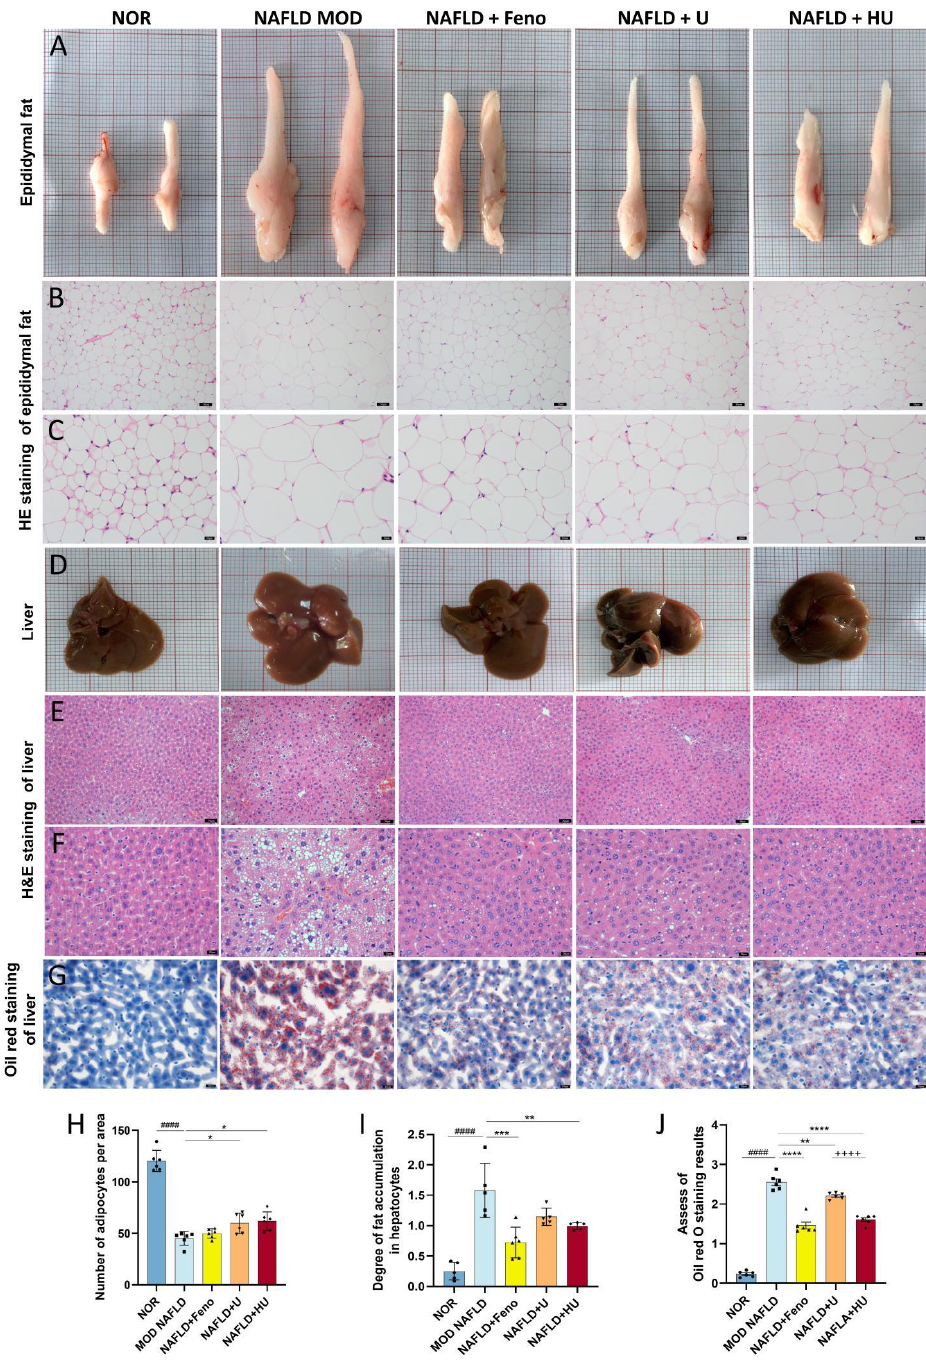
Figure 8. Effects of U and HU on epididymal fat and liver in NAFLD mice. ( A ) Epididymal fat morphology. Epididymal fat H&E staining magnification 200× (scale bar = 50 µm) ( B ) and 400× (scale bar = 20 µm) ( C ). ( D ) Morphology of liver tissue. H&E stained liver tissue, magnification 200× (scale bar = 50 µm) ( E ) and 400× (scale bar = 20 µm) ( F ). ( G ) Oil red stained liver tissue, magnification 400× (scale bar = 20 µm). ( H ) Semiquantitative assessment of H&E stained epididymis adipose tissue. ( I ) Semiquantitative assessment of H&E stained liver tissue. ( J ) Semiquantitative assessment of oil red stained liver tissue. Data are shown as mean ± SEM. #### p < 0.01 vs. the NOR group; * p < 0.05, ** p < 0.01, *** p < 0.005, **** p < 0.0001 vs. MOD group; ++++ p < 0.0001 vs. U